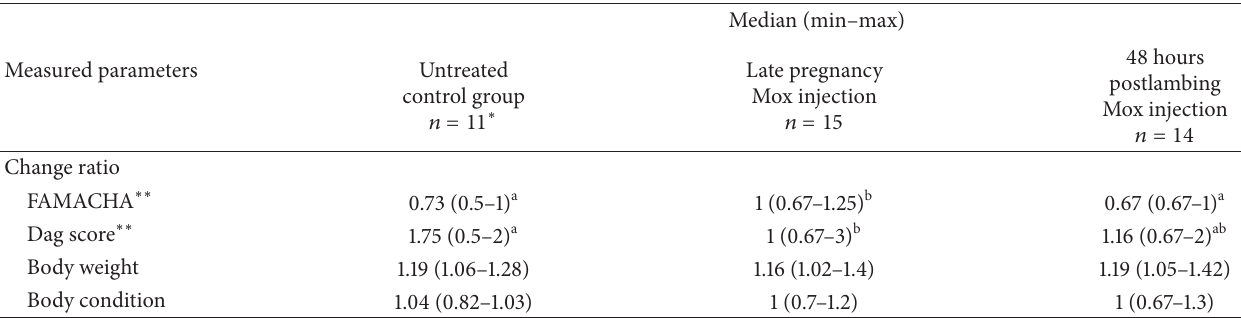
Table 2: Treatment-induced differences in the median of ratio change of clinical (FAMACHA© and Dag score) and zootechnical (body weight and body condition)